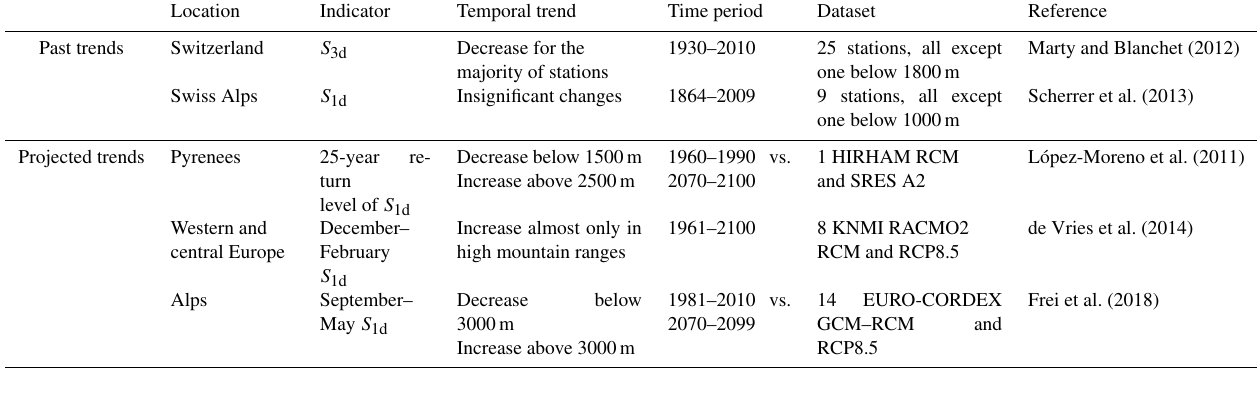
Table 1. Temporal trends in extreme snowfall with respect to elevation in and around the French Alps. Elevations are in meters above sea